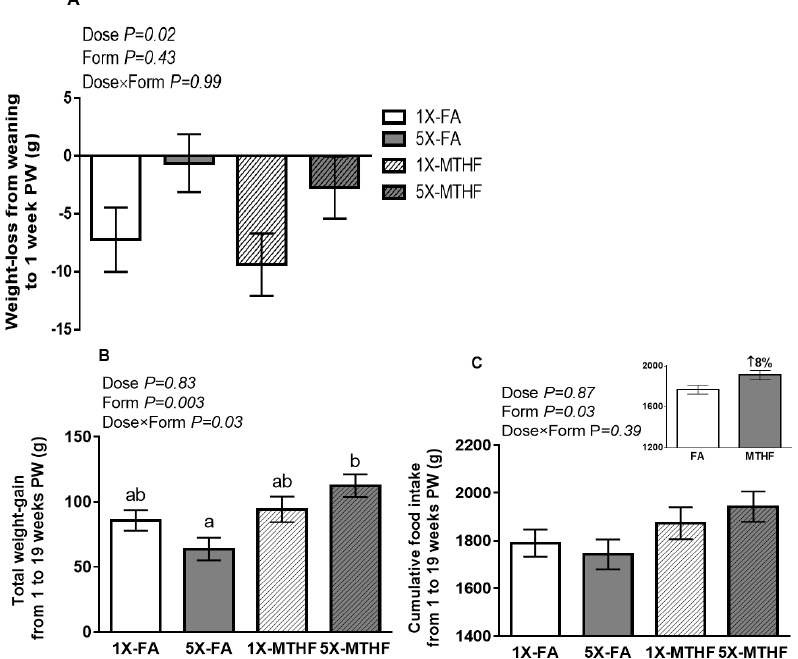
Figure 1. ( A ) Weight-loss from weaning to 1-week post-weaning (PW), ( B ) total weight-gain at 19-weeks PW and ( C ) cumulative food intake calculated from 1- to 19-weeks post-weaning (PW). n = 10–12/group. Values are Least Square Mean ± S.E.M. Analyzed by Two-way ANOVA. ab Signifi- cantly different by Tukey Post-hoc Analysis. Abbreviations: AIN-93G rodent diet with 1X (recom- mended, 2 mg/kg) or 5X folic acid (FA) or equimolar [6S]-5-methyltetrahydrofolic acid calcium salt (MTHF) at 1X (2.1 mg/kg) or 5X (10.4 mg/kg) levels. The gestational diets did not affect litter size (1X-FA 12.9 ± 0.6, 5X-FA 12.5 ± 0.6, 1X- Table 3. Body composition upon parturition and at 19-weeks post-weaning (PW) of dams fed FA or MTHF pregnancy diets. FA